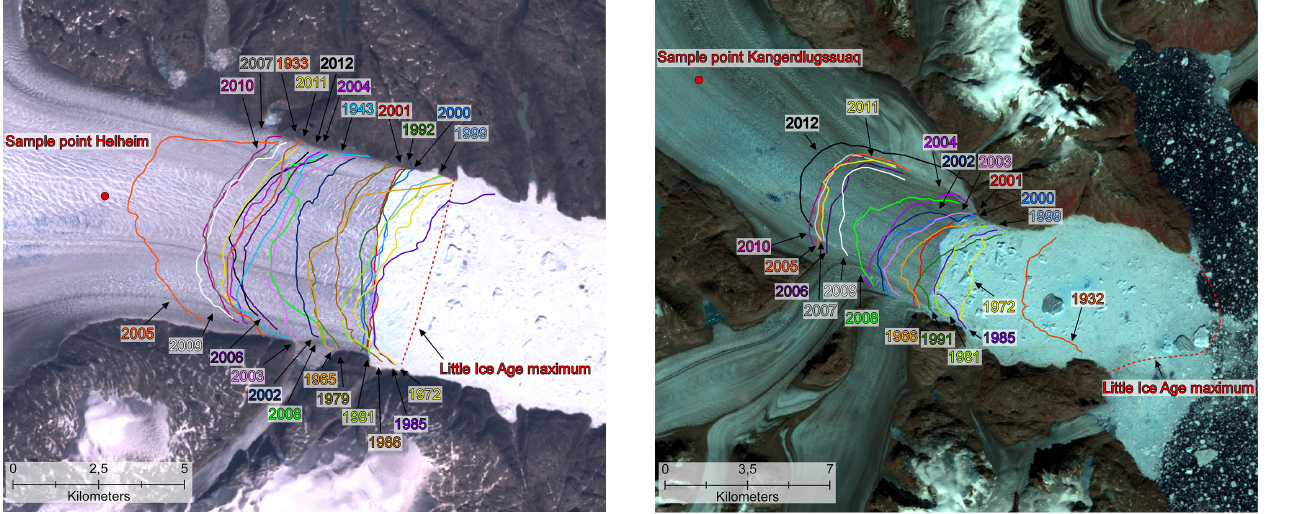
Figure 9. Frontal position of Kangerdlugssuaq Glacier obtained from Oblique aerial image (1932) and adopted from Bjørk et al. (2012), Corona satellite (1966), Vertical aerial image (1972 and 1981), Landsat 5 TM (1985 and 1991), and Landsat 7 ETM+ (1999– 2012). The red circle represents the location of the time series shown in Fig.